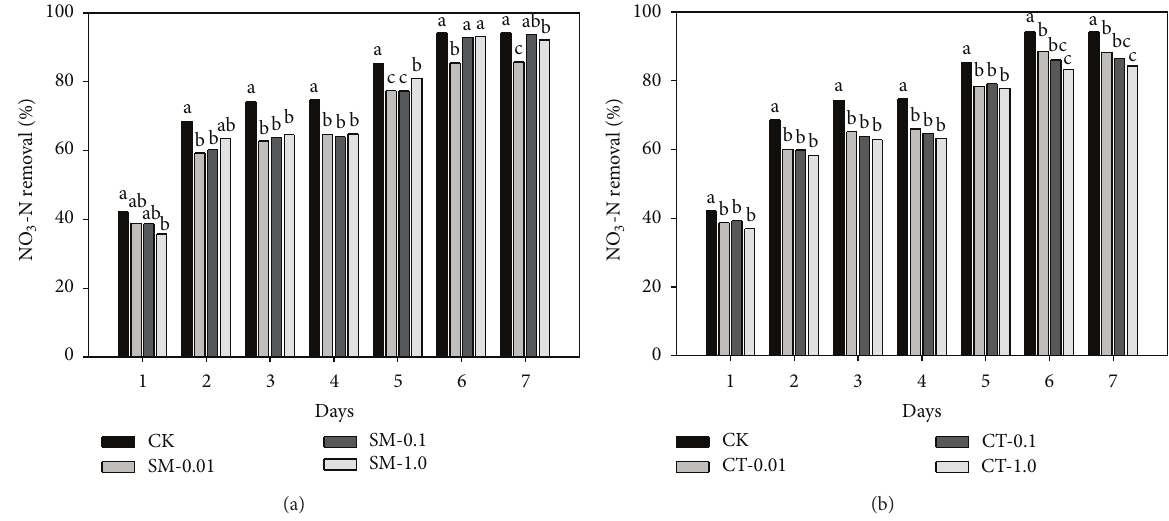
Figure 1: Comparison of nitrate (NO 3 -N) removal over time in groundwater under denitrifying conditions in the absence (CK) or presence of (a) sulfamethazine (SM-0.01, -0.1, and -1.0mg/L) and (b) chlortetracycline (CT-0.01, -0.1, and -1.0mg/L). Same letters above each bar indicate no difference between different treatments at a 0.05 significance level of the Tukey’s studentized range test.